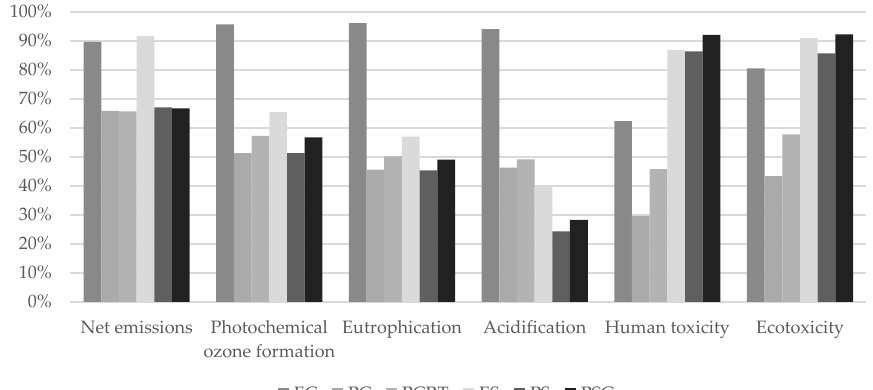
Figure 6. Potential environmental impacts after the integration of the agricultural and industrial phases. Net emissions: negative values.